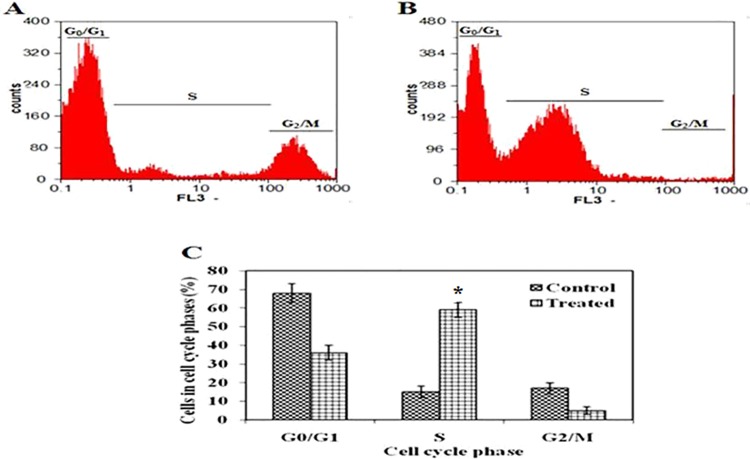
Effects of EAF on cell cycle distribution in EAC cells.The percentages of each cell cycle were evaluated by flow cytometry based on mean values obtained from two independent experiments. Results are expressed as mean ± S.D. as shown in (C). A and B represent flow cytometric analysis of untreated control and EAF treated EAC mice, respectively. The X-axis (FL3) represents the intensity of PI staining, which is directly proportional to the amount of DNA in cells, and theY-axis represents cell number. *p < 0.05 is EAF treated tumor bearing mice compared with untreated control group.